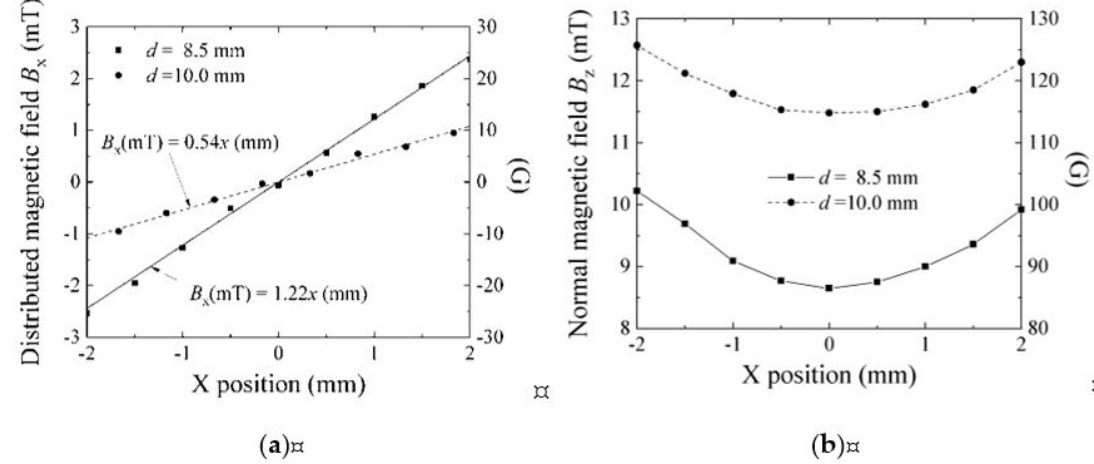
Figure 14. The distribution of the magnetic field generated by a ring-shaped magnet. ( a ) Variation of B x as a function of x. ( b ) Variation of B z as a function of x .